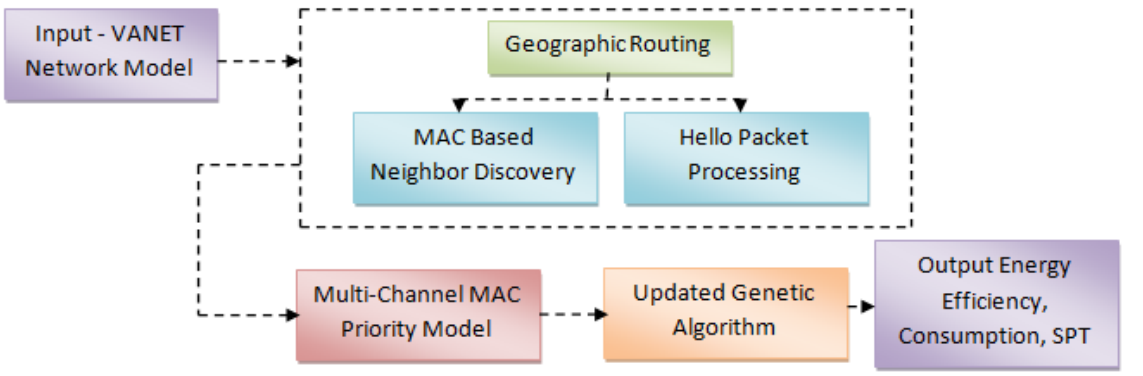
Figure 2. Input/output with system legacy model.